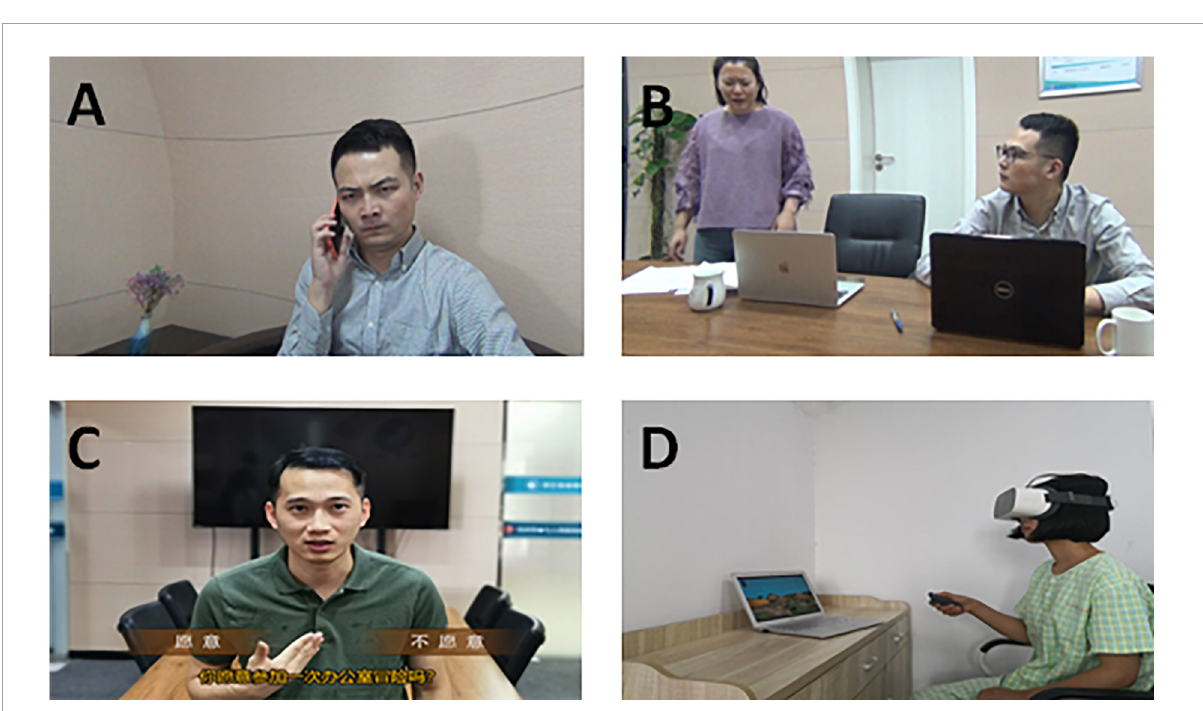
FIGURE2 Example of virtual reality based social cognition and interaction training (VR-SCIT) scenarios. (A) VR screen shot of phase-I (recognize emotions): A person was answering a phone (voice shielding) with an angry expression on his face, and participants were asked to judge the emotion by recognizing facial cues. (B) VR screen shot of phase-II (figuring out situations): After the girl left, another person came in looking for something and messed up her desk. When the girl came back, she blamed the boy for messing up her desk without knowing the facts. (C) VR screen shot of phase-III (checking it out): This was a Role-Play Game about office stories, participants needed to make the right choices about identifying emotions, thoughts and behaviors. (D) The scene of VR-SCIT